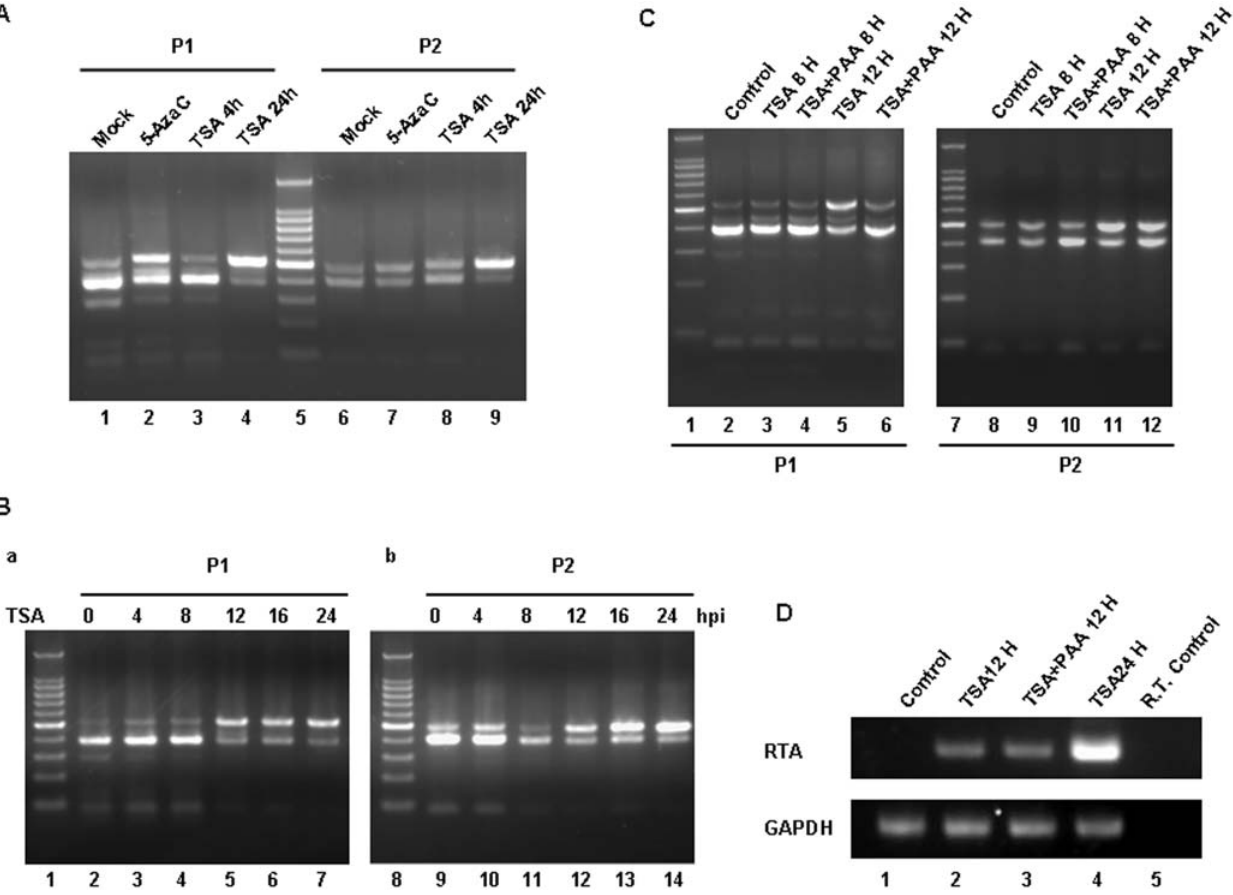
Figure 5. Passive demethylation at RTA promoter was associated with MHV-68 reactivation. (A) COBRA of methylation status at RTA P1 and P2 promoter. S11E cells were stimulated with 5-AzaC (10 m M, 24 hrs), TSA (200 ng/ml, 4 hrs), TSA (200 ng/ml, 24 hrs) or mock treated for COBRA. (B) Time course of methylation status change at the P1 and P2 fragments of RTA promoter in S11E cells. S11E cells were treated with TSA (200 ng/ml), and at 0, 4, 8, 12, 16 or 24 hrs post-induction, DNA was extracted for COBRA. (C) COBRA of methylation status at RTA promoter with PAA treatment. S11E cells were treated with TSA (200 ng/ml) and/or PAA (200 m g/ml) for 8 or 12 hrs, and DNA extracted for COBRA of the RTA P1 and P2 methylation status. (D) RT-PCR analysis of MHV-68 RTA mRNA expression after TSA plus PAA treatment. S11E cells were stimulated with TSA (200 ng/ml) 12 hrs, TSA (200 ng/ml) plus PAA (200 m g/ml) 12 hrs or TSA (200 ng/ml) for 24 hrs, and then total RNA isolated for RT-PCR. Analysis of GAPDH served as a